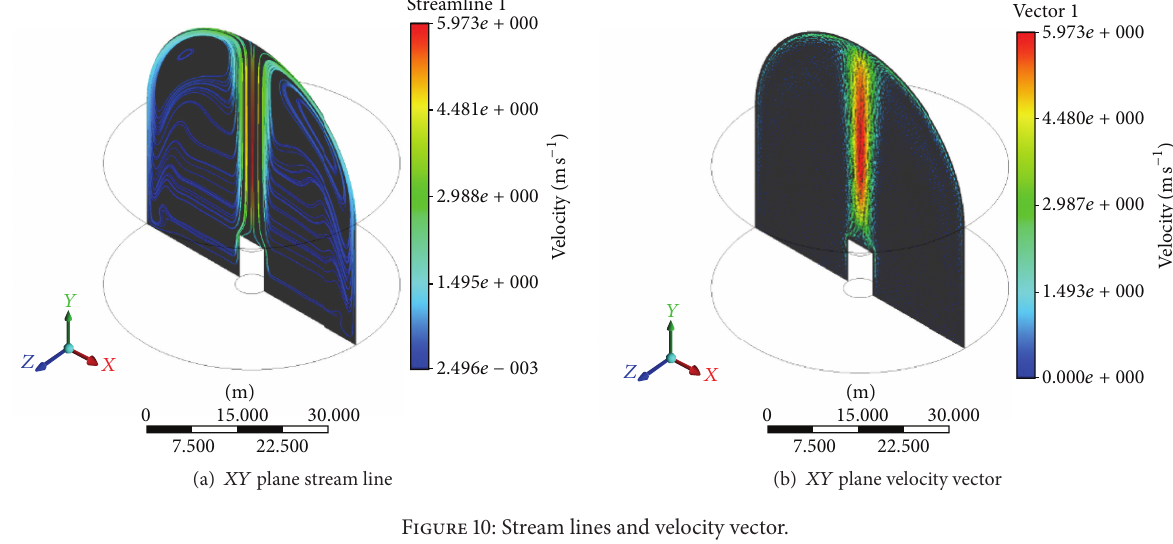
Figure 10: Stream lines and velocity vector.